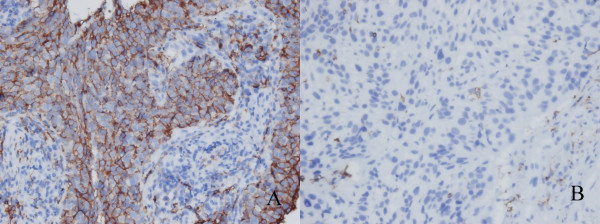
Positive membrane staining of HLA-DR in undifferentiated carcinoma, 400 × (A); negative staining of HLA-DR in carcinoma cellsand dispersed lymphocytes with HLA-DR expression, 400 × (B).